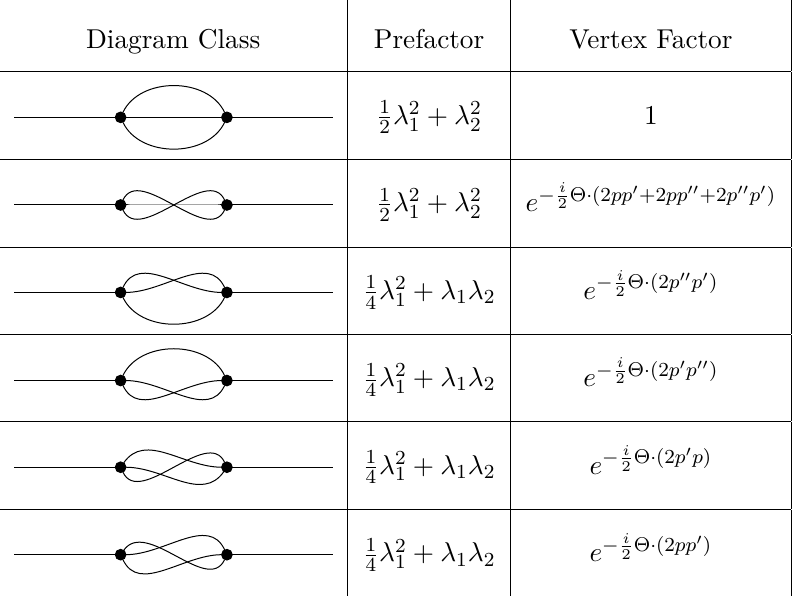
Table 2. 2-loop melon